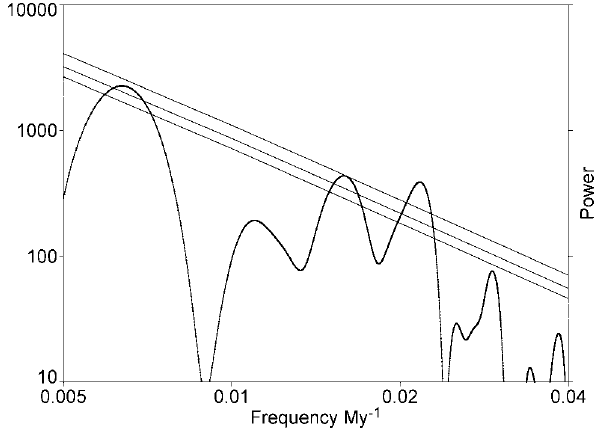
Figure 2. A logarithmic plot of the power spectrum of fluctuations (determined by Fast Fourier Transform) against frequency in My 2 1 . Higher frequency fluctuations are not shown due to sampling limitations (too close to the interval timescale). The total power is dominated by the area under a few high peaks which exceed confidence limits. These peaks are, from left to right period T=1/f 157 My, 63 My, and 46 My. Fluctuations outside the plotted frequency range are not shown due to sample limitations (interval length and overall time range). The parallel lines indicate significance at levels p=0.05, 0.01, and 0.001 against the probability of any such peak arising against the spectral background. Equivalent peaks appear in an analysis based on Lomb-Scargle methods, which do not require binning and interpolation.